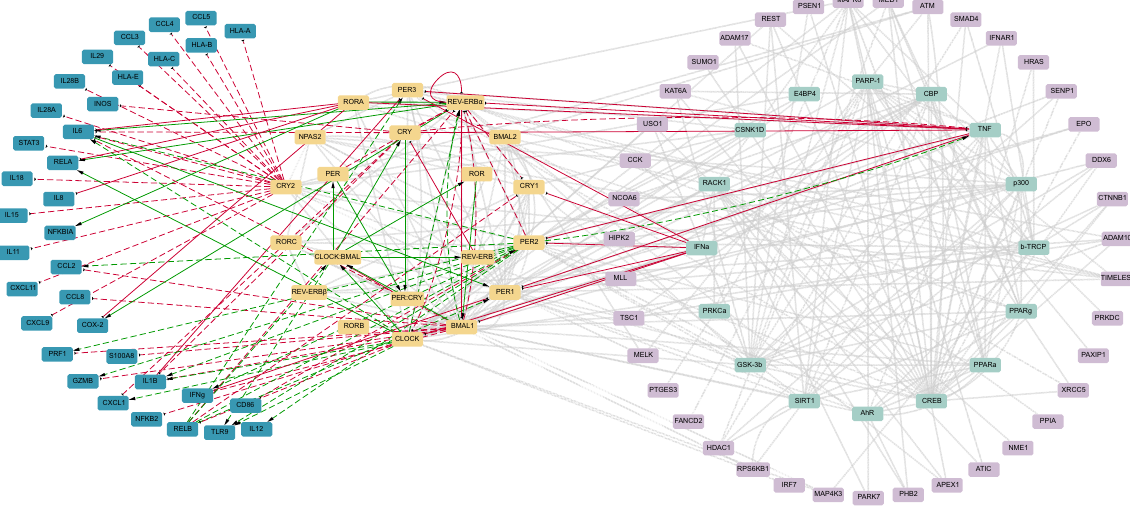
Figure 1. The network of clock-immune related genes (NCIRG) connects elements of the circadian clock network and the immune system. An enrichment analysis on immune-related GO terms and KEEG pathways of the NCRG, and manual curation based on published data of immune-related genes with interactions with the CCN added a set (35) of immune-related genes (dark blue) to the network. Orange, light green and light purple elements represent the core-clock network (CCN, 20 elements), the extended core-clock network (ECCN) and the network of clock-related genes (NCRG), respectively. Grey lines represent the connection between genes previously published in the NCRG; green and red lines refer to positive and negative (respectively) interactions between newly added immune-related genes and the CCN, based on published data. Black arrows indicate the direction of each interaction. Dashed lines mark the interactions found in modified in vitro / in vivo models. It is important to notice that in some of the studies used for the construction of the network double KD or KO animals/cells were used. In such cases, it was not possible to specify the exact gene responsible for the reported effect on the immune genes, CRY, PER, ROR and REV-ERB were used to refer to the gene family. The direction of the effect is represented by an arrow for activation and a dead end arrow for the inhibition pointing to the affected